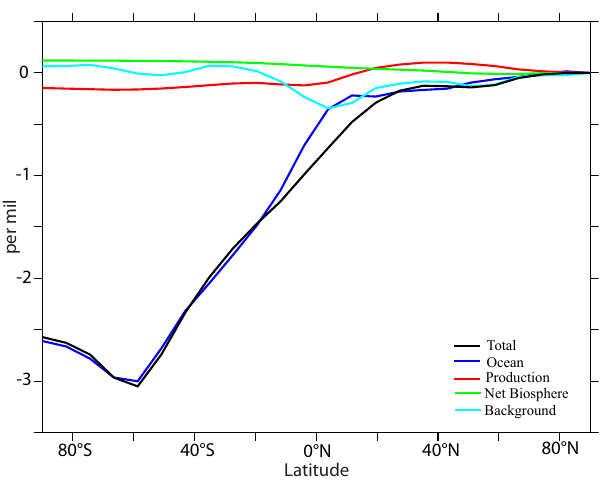
Fig. 3. The mean meridional structure of 1 14 C in the atmo- spheric boundary layer of the atmospheric transport model under steady-state cyclostationary conditions, shown as deviations from the 1 14 C activity simulated at the North Pole. Shown are the to- tal structure of the interhemispheric gradient (black), the compo- nent due to sea-air fluxes of CO 2 and 14 CO 2 (blue), the compo- nent due to spallation/production of 14 CO 2 in the atmosphere (red) and the component due to the net biosphere disequilibrium (green). (per mil). The 1 14 C for each of these components is calculated as the 14 CO 2 from the specific process being considered and the to- tal CO 2 from all processes. The background component reflects a globally uniform initial value of 14 C plus the seasonal rectification in 14 C for the terrestrial biosphere described in Sect. 2.2, divided by the spatially varying CO 2 from all processes. This background value is necessary in order to ensure that the other curves sum to the black